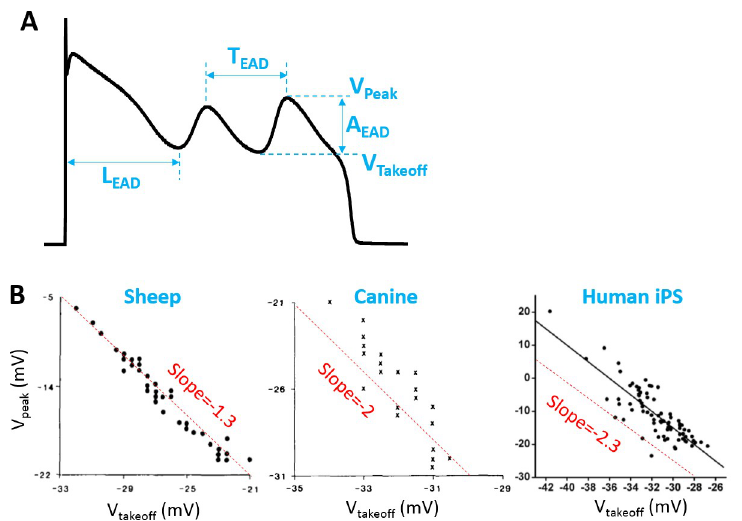
Fig 1. EAD properties. A . Definitions of A EAD , T EAD , L EAD , V peak , and V takeoff . B . V peak versus V takeoff from a short segment of sheep Purkinje fiber [1], a short segment of canine Purkinje fiber [1], and a human-induced pluripotent stem cell-derived cardiomyocyte [2]. The dashed straight lines were added as references for the slopes of the negative linear correlations of the data.